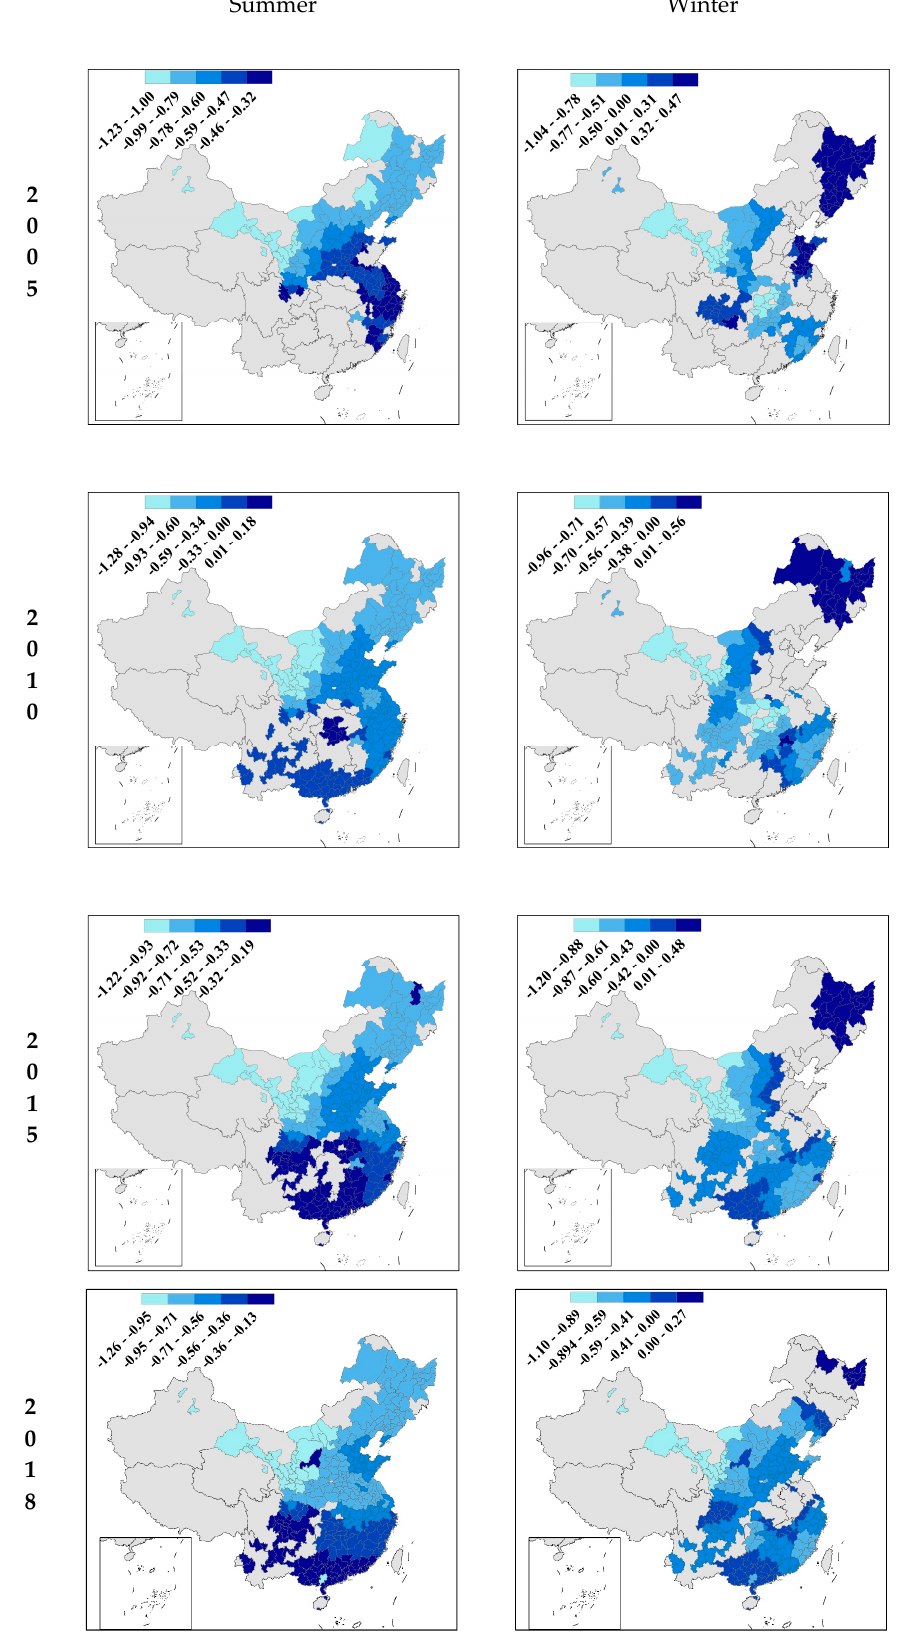
Figure 9. Spatial distributions of the coefficients of ∆ NDVI for the daytime MGWR model in the summer and winter of 2005, 2010, 2015, and 2018.